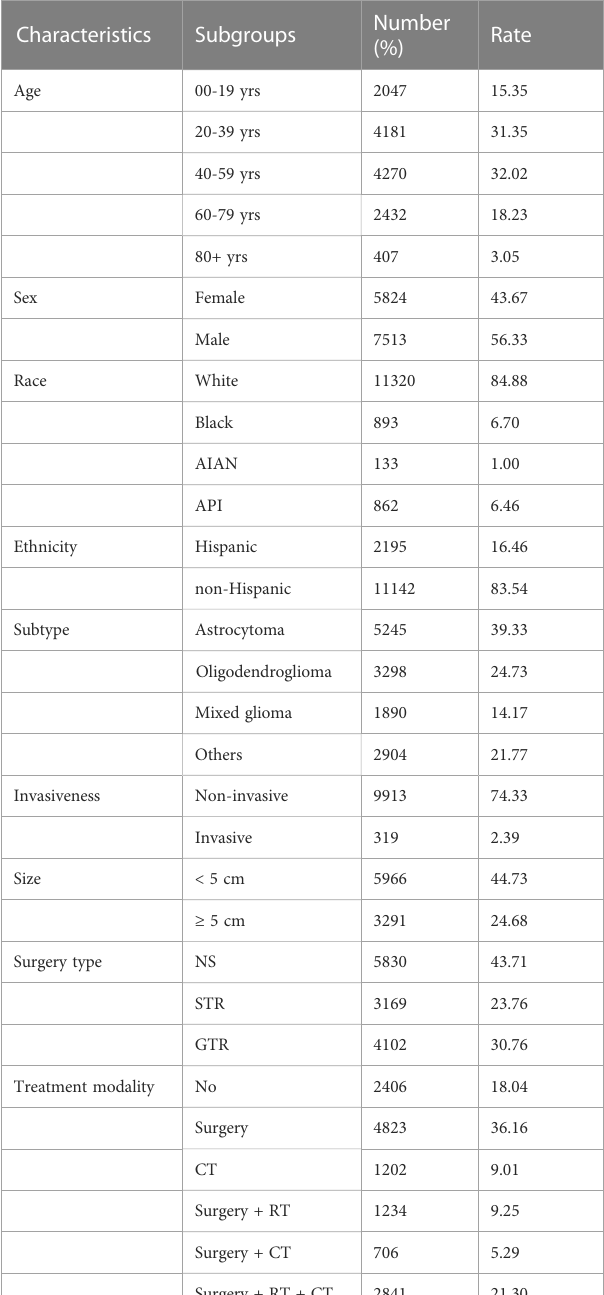
TABLE 1 Patient baseline characteristics.